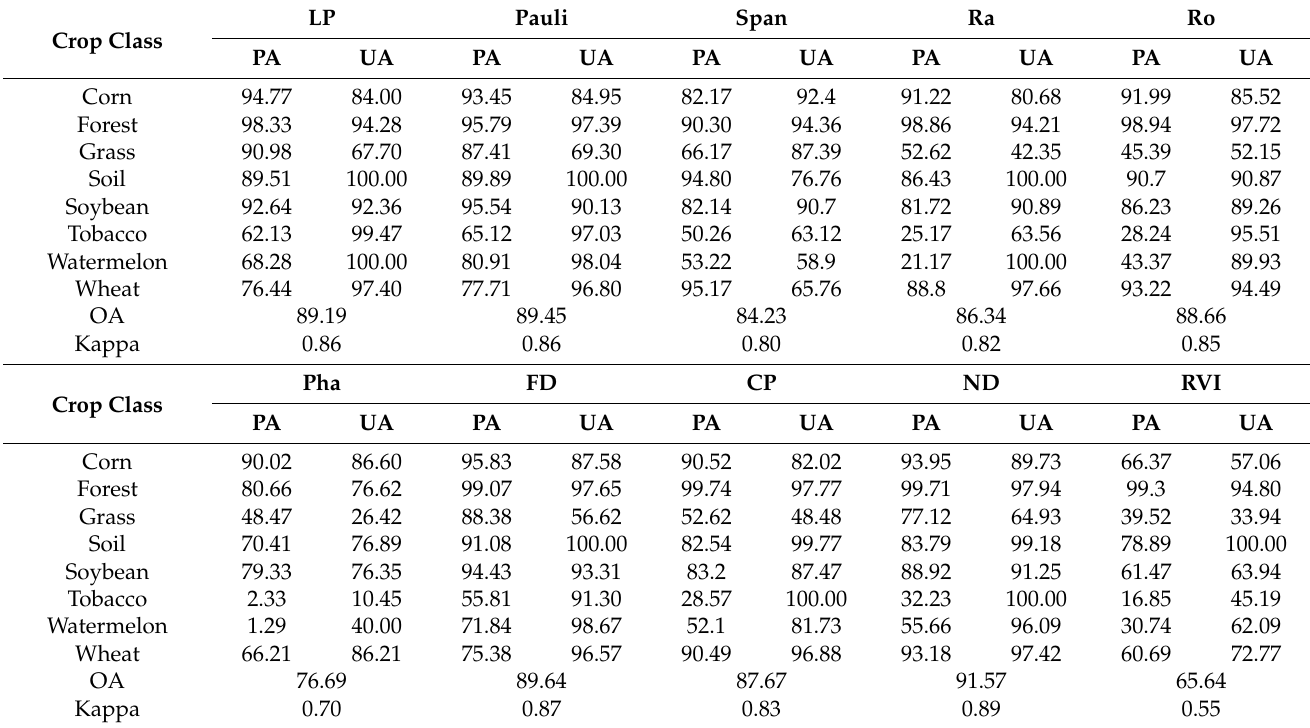
Table 5. Accuracy assessment of RF classifications using different combinations of polarimetric observables. Note that abbreviations are explained in Table